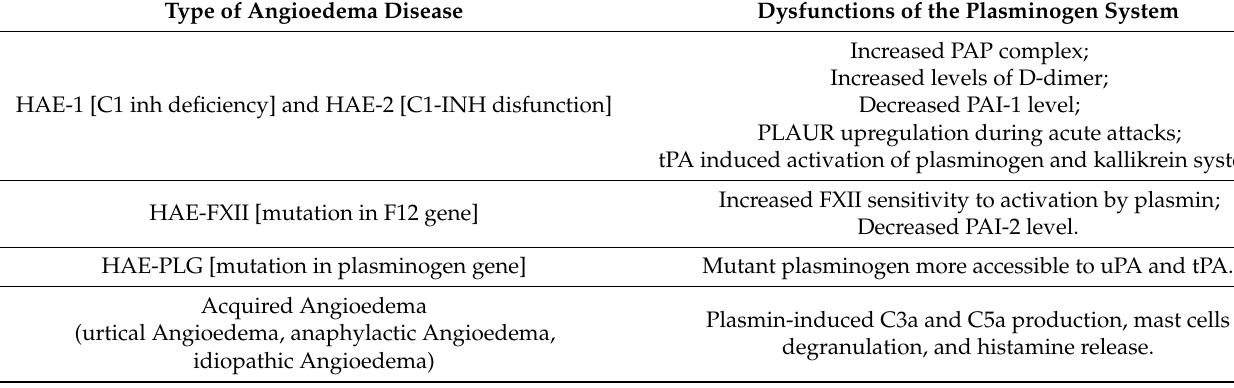
Table 1. Summary table of the fibrinolytic disorders in the different forms of angioedema. Type of Angioedema